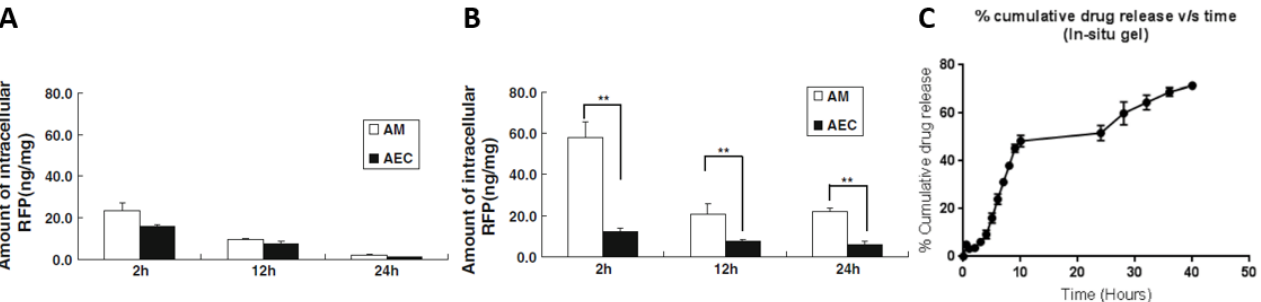
Figure 8. ( A , B ) Intracellular rifampicin (RFP) concentrations per mg of protein in alveolar macrophages (AM) (white) and in type II alveolar epithelial cells (AECs) (black) after pulmonary administration of 1 mg/kg in rats. n > 3. Symbol ** denotes p < 0.05. ( A ) Results for free RFP. ( B ) Results for RFP-loaded solid lipid nanoparticles. Reference [98], copyright (2022) by Copyright Clearance Center, with permission from Springer Nature. ( C ) Percentage of RFP released from chitosan nanoparticles over time in artificial synovial fluid. Reference [104], copyright (2022) by Copyright Clearance Center, with permission from Springer Nature.